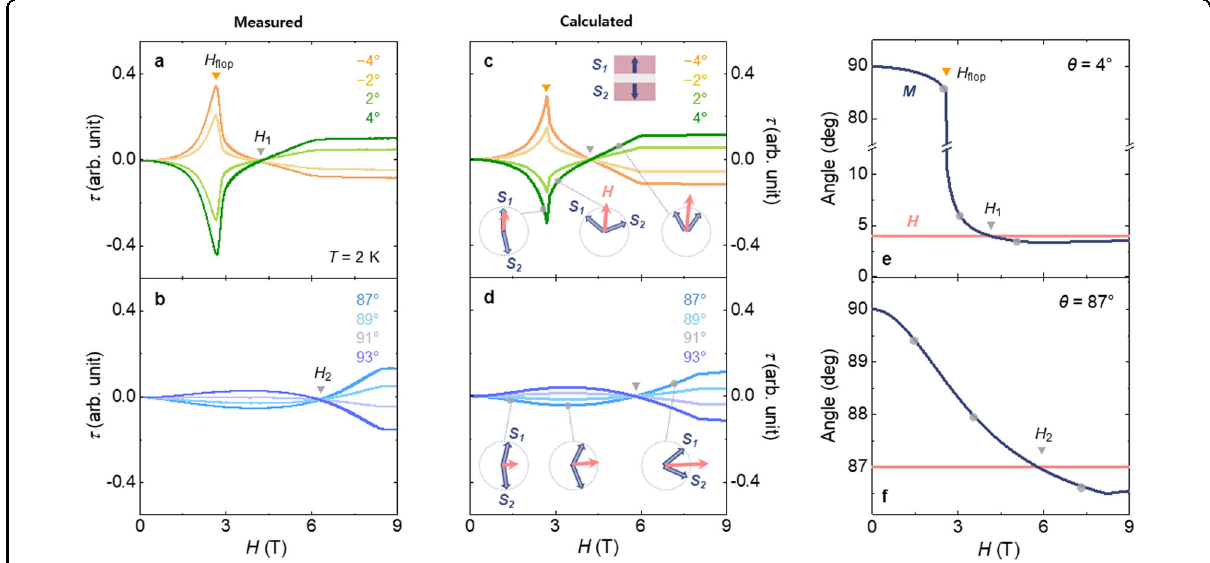
Fig. 2 Anisotropic magnetic torques at 2 K. a H dependence of the magnetic torque, τ , measured at θ = − 4, − 2, 2, and 4° for T = 2 K. The orange and gray inverted triangles represent the occurrence of spin fl ops at H fl op and the crossing of the zero τ value at H 1 , respectively. b H dependence of τ measured at θ = 87, 89, 91, and 93° for T = 2 K. The gray inverted triangle indicates the crossing of the zero τ value at H 2 . c Calculated H -dependent τ for θ = − 4, − 2, 2, and 4°. The schematics illustrate the angle variation of the magnetic moments as H is increased at θ = 4°. d Calculated H - dependent τ for θ = 87, 89, 91, and 93°. The schematics illustrate the angle variation of the magnetic moments as H is increased at θ = 87°. e Angular change in the net magnetization upon increasing H at θ = 4°. f Angular change in the net magnetization upon increasing H at θ =